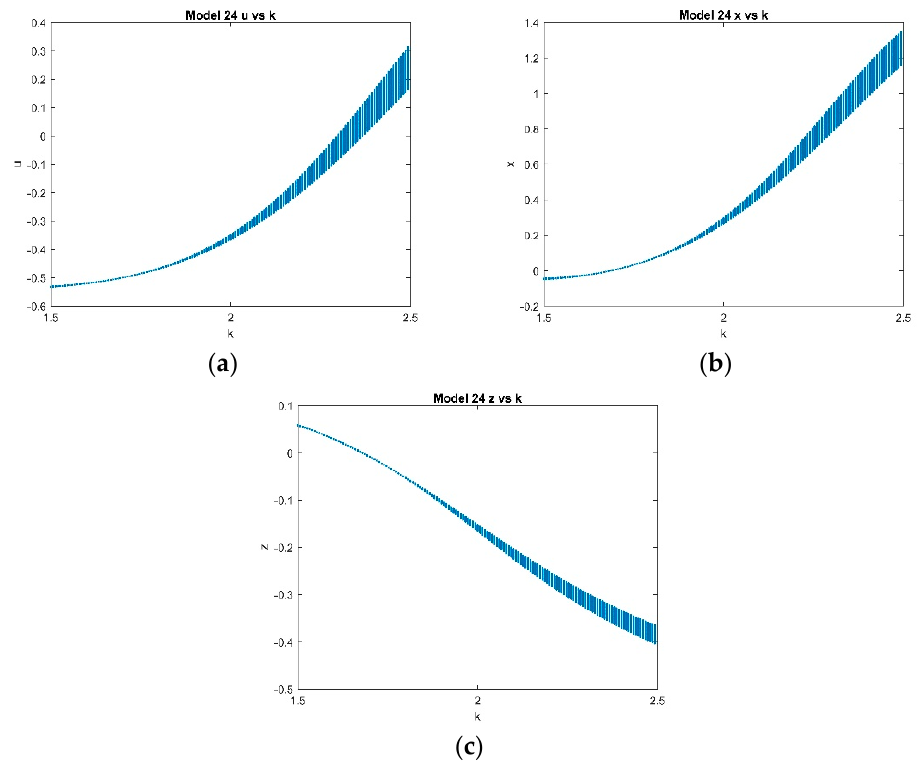
Figure 21. ESDDFD2 model (24); ( a ) u vs. k , ( b ) x vs. k , ( c ) z vs. k , at p = 1, α 5 = 0.3, k ∈ [ 1.5, 2.5 ]